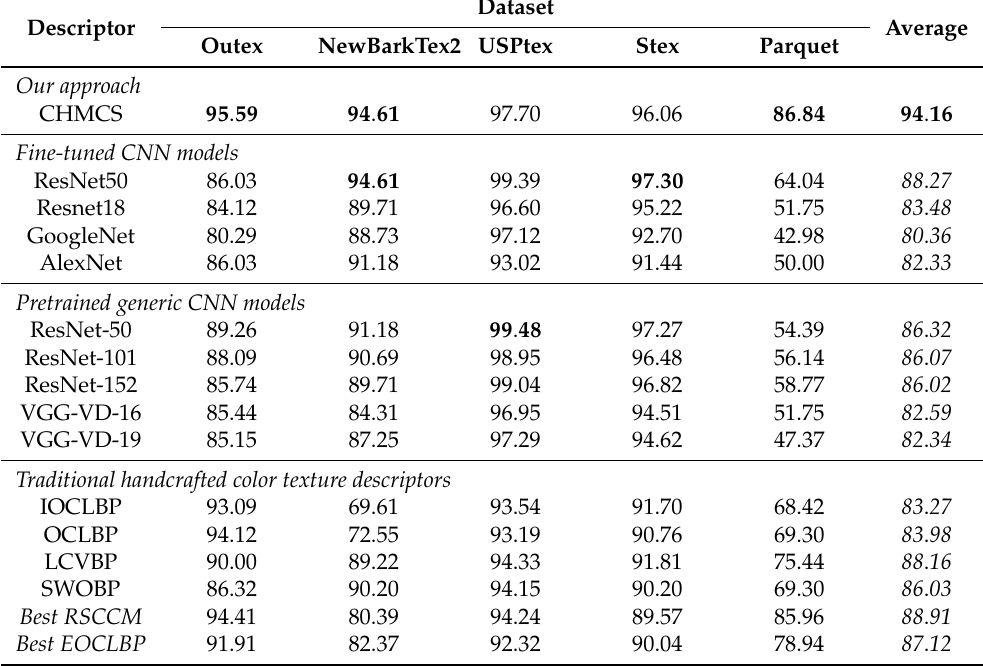
Table 9. Comparison with handcrafted descriptors and deep learning approaches. Mean classification rates are provided (written in italic) for each approach across the five datasets. For each dataset, the best results are written in